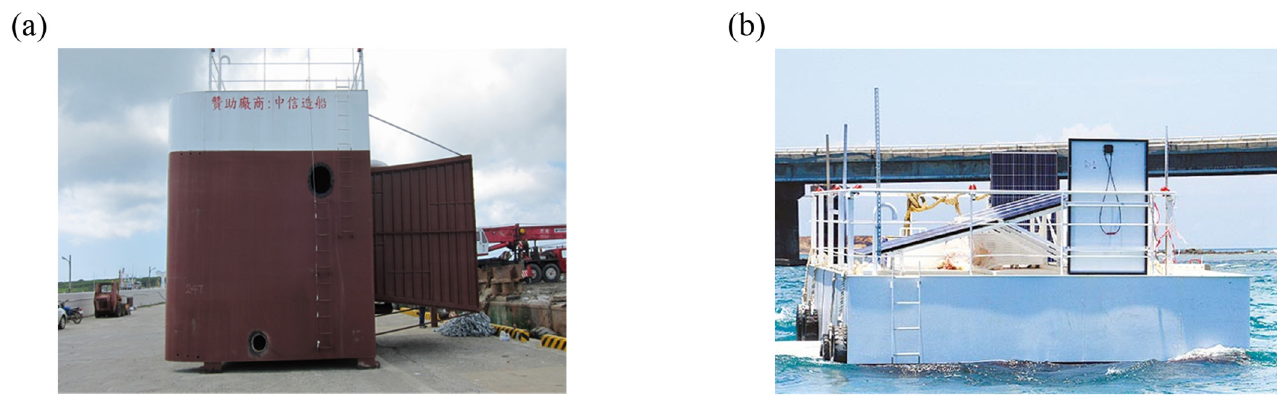
Figure 3. Prototypes of NSYSU designed ( a ) floating nozzle-diffusor duct (NDD) power generation system ( b ) deployed successfully in the sea area near the Penghu cross-sea bridge in 2013.